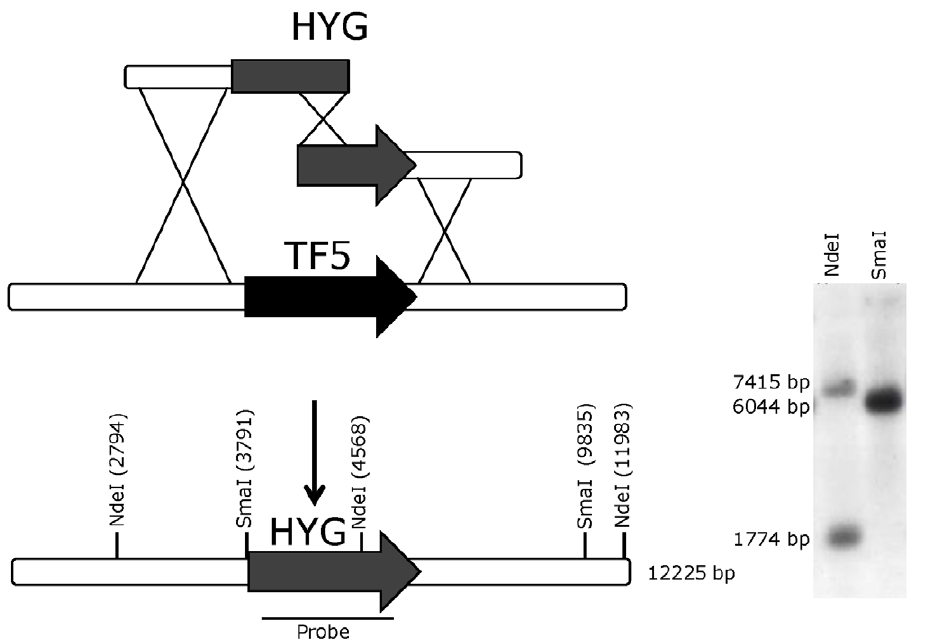
Figure 1. Graphical illustration of the gene deletion procedure exemplified with by insertion of hygromycin resistance marker into the oafA locus. (A) Bipartite substrate, locus and predicted resultant genomic locus. (B) Southern analysis of transformants for site specific integration of the construct. Genomic DNA was digested with either NdeI or SmaI. The position of the probe used is shown in (A).